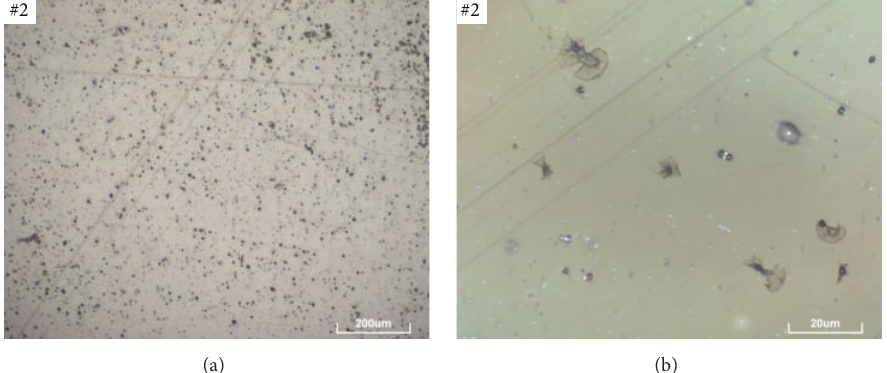
Figure 4: Optical image of platelets on surface of PET polymer treated in oxygen plasma (#2) after incubation with fresh blood at two different magnifications ((a) and